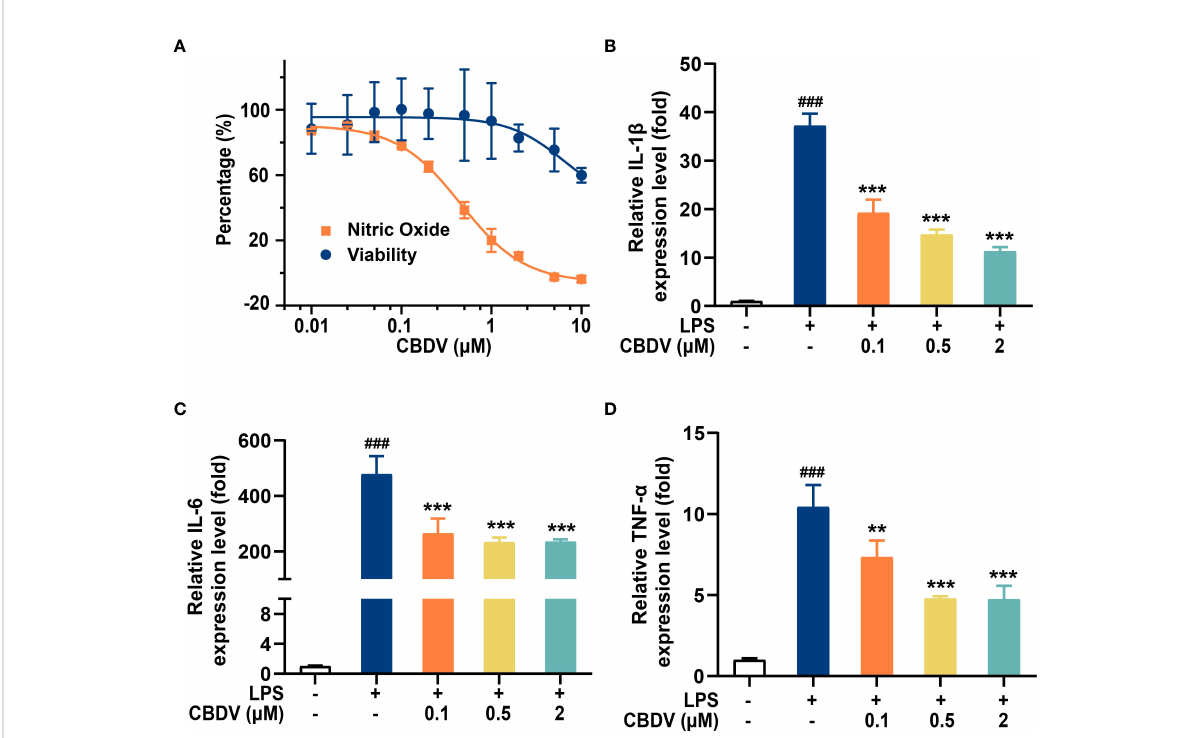
FIGURE 5 CBDV inhibits LPS-induced NO overproduction (A) as well as the pro-in fl ammatory factors IL-1 b (B) , IL-6 (C) , and TNF- a (D) mRNAs expression. All the data represented the mean ± S.E.M.; the number of independent cell culture preparations = 3. The P-value was set at ### P < 0.001 versus the control group; **P < 0.01, ***P < 0.001 versus the LPS group.